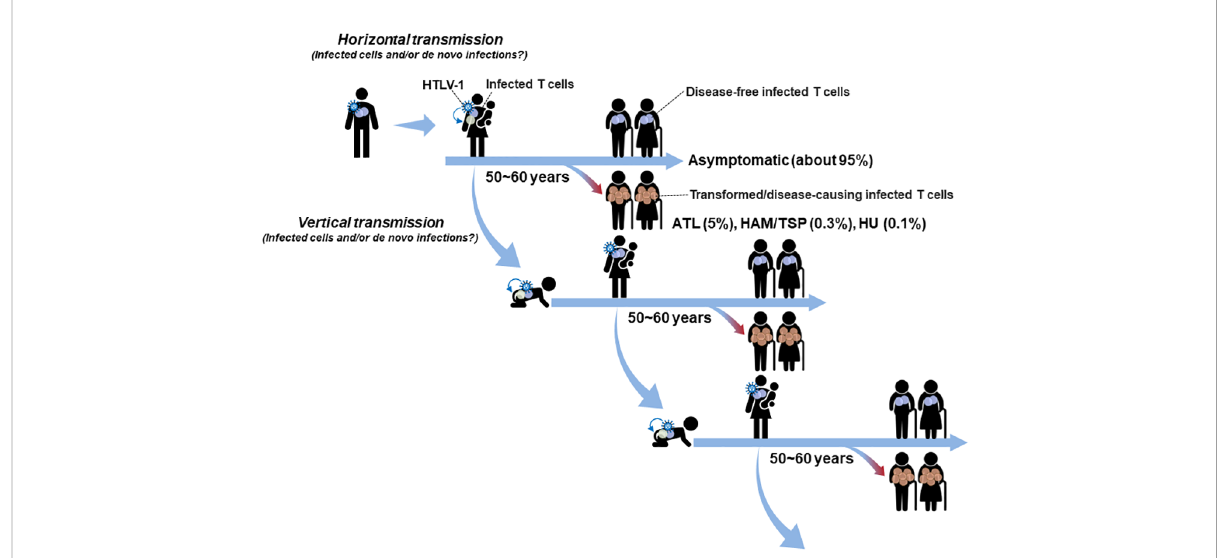
FIGURE 1 Mode of HTLV-1 transmission in the human life cycle: HTLV-1 is mainly transmitted by vertical mother-to-child transmission via breast milk or by horizontal sexual transmission and blood transfusion. Both modes of transmission, i.e., the transmission of infected T cells and/or infectious virions, are possible. Although HTLV-1 causes ATL, HAM/TSP, and HU, only about 5% of carriers develop diseases (mostly ATL) and about 95% of carriers remain asymptomatic, in which infected cells maintain a disease-free latent state for their lifetimes. Especially, HTLV-1 infected cells transferred from the carrier mother as well as de novo established in the infant are expected to quickly be immortalized and remain in a stable latent state for decades beyond the age to transmit the virus to the next